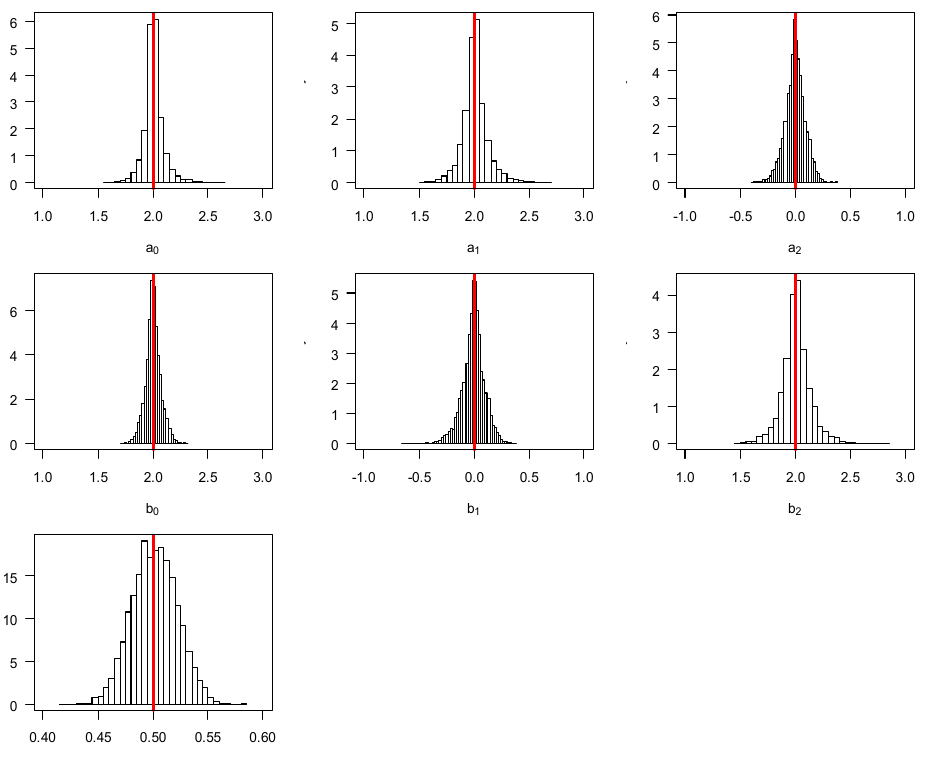
Figure 2. Sampling distributions of 5000 simulations for the parameters in RegCusp model. The x -axis denotes the range of the simulated parameters and y -axis denote the range of the associated probability